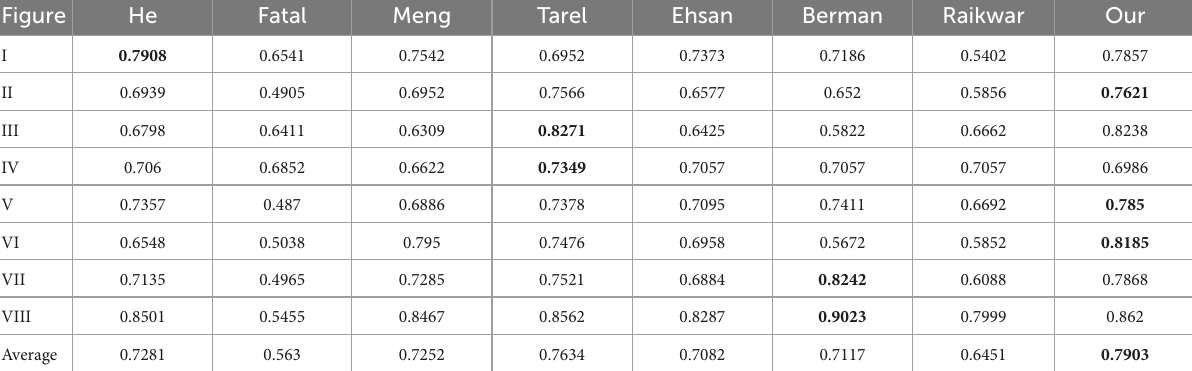
TABLE 2 Comparison of structural similarity index measurement (SSIM) of the defogging images. Figure He Fatal Meng Tarel Ehsan Berman Raikwar